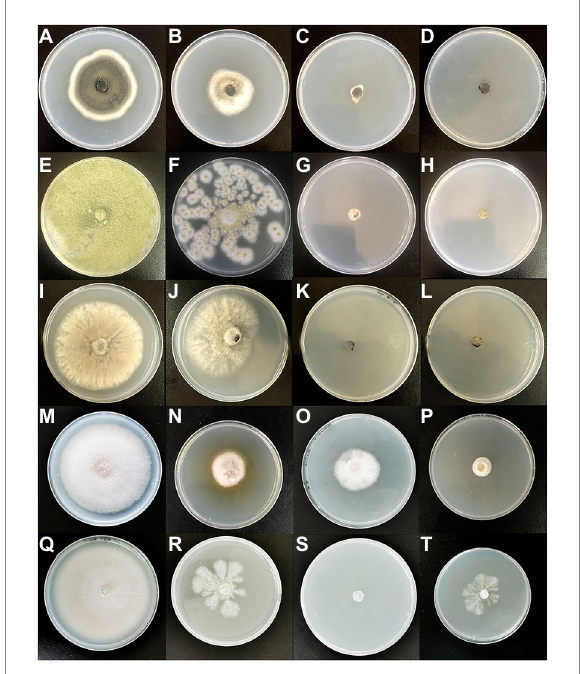
FIGURE 1 Double Petri-dish assay for antifungal activity of VOCs produced by Ceratocystis fimbriata . (A) Alternaria solani growing on a potato dextrose agar (PDA) medium for 7 days as control. (B) Alternaria solani treated by C. fimbriata growing on a PDA medium. (C,D) Treated by 2-Phenylethanol and Benzaldehyde. (E) Aspergillus flavus growing on a PDA medium for 7 days as control. (F) Colony color fades and Area reduction treated by C. fimbriata . (G,H) Aspergillus flavus treated by 2-Phenylethanol and Benzaldehyde. (I) Botrytis cinerea growing on a PDA medium for 7 days as control. (J) Botrytis cinerea treated by C. fimbriata growing on a PDA medium. (K,L) Botrytis cinerea treated by 2-Phenylethanol and Benzaldehyde. (M) Fusarium oxysporum growing on a PDA medium for 7 days as control. (N) Extra pigment was produced by F. oxysporum treated by C. fimbriata growing on a PDA medium. (O,P) Fusarium oxysporum treated by 2-Phenylethanol and Benzaldehyde. (Q) Monilinia fructicola growing on a PDA medium for 7 days as control. (R) Monilinia fructicola treated by C. fimbriata was unable normal colony morphology was unable to form, and the colony morphology is the snowflake. (S) Monilinia fructicola treated by 2-Phenylethanol. (T) Monilinia fructicola treated by Benzaldehyde normal colony morphology was unable to form, and the colony morphology is the